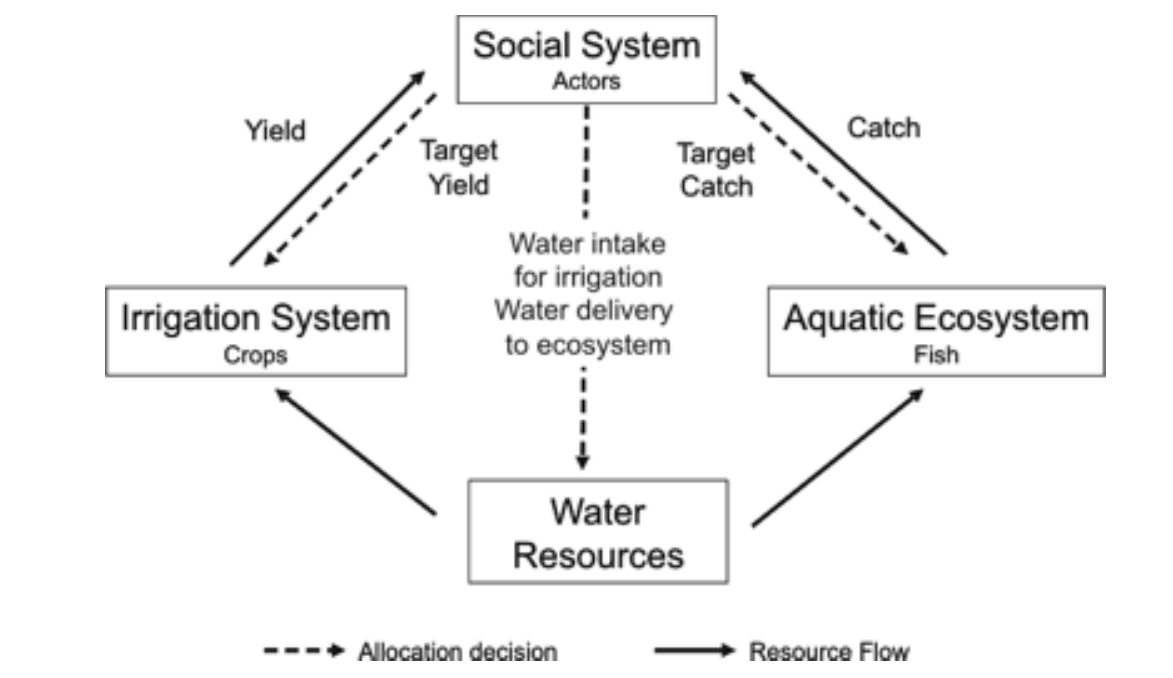
Fig. 2. Conceptual model of the social-ecological system in the river delta showing the major linkages between the water resources that supply the irrigation system and the aquatic ecosystem, which both support the social